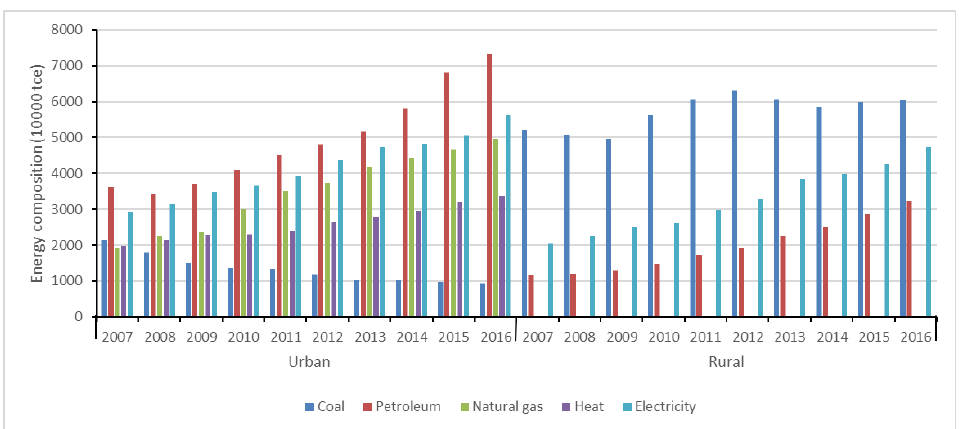
Figure 2. Composition of residential energy consumption in urban and rural China (t coal equivalent).